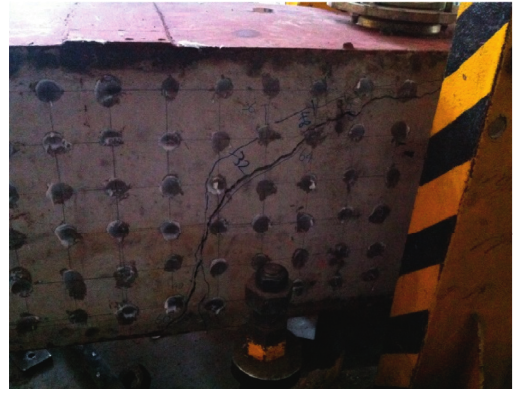
Figure 12: Inclined crack.